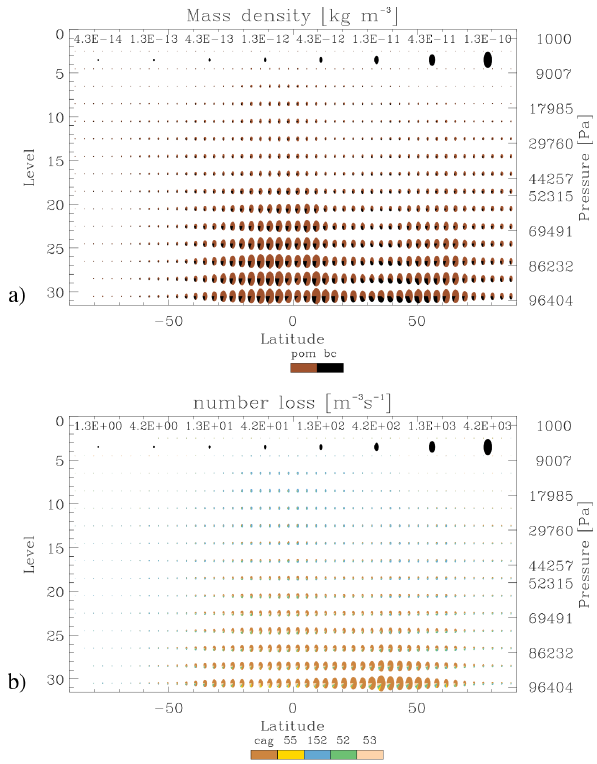
Figure 9. Zonal distribution of annual densities (a) and tenden- cies (b) of the hydrophobic Aitken mode. The colors indicate ei- ther species (defined in Table 3) or processes (defined in Table 2). The pie chart shows fractional contributions, while the radius of the pie indicates the zonally averaged density or tendency (logarithmic scale as shown in black at the top of the panels a and b ).